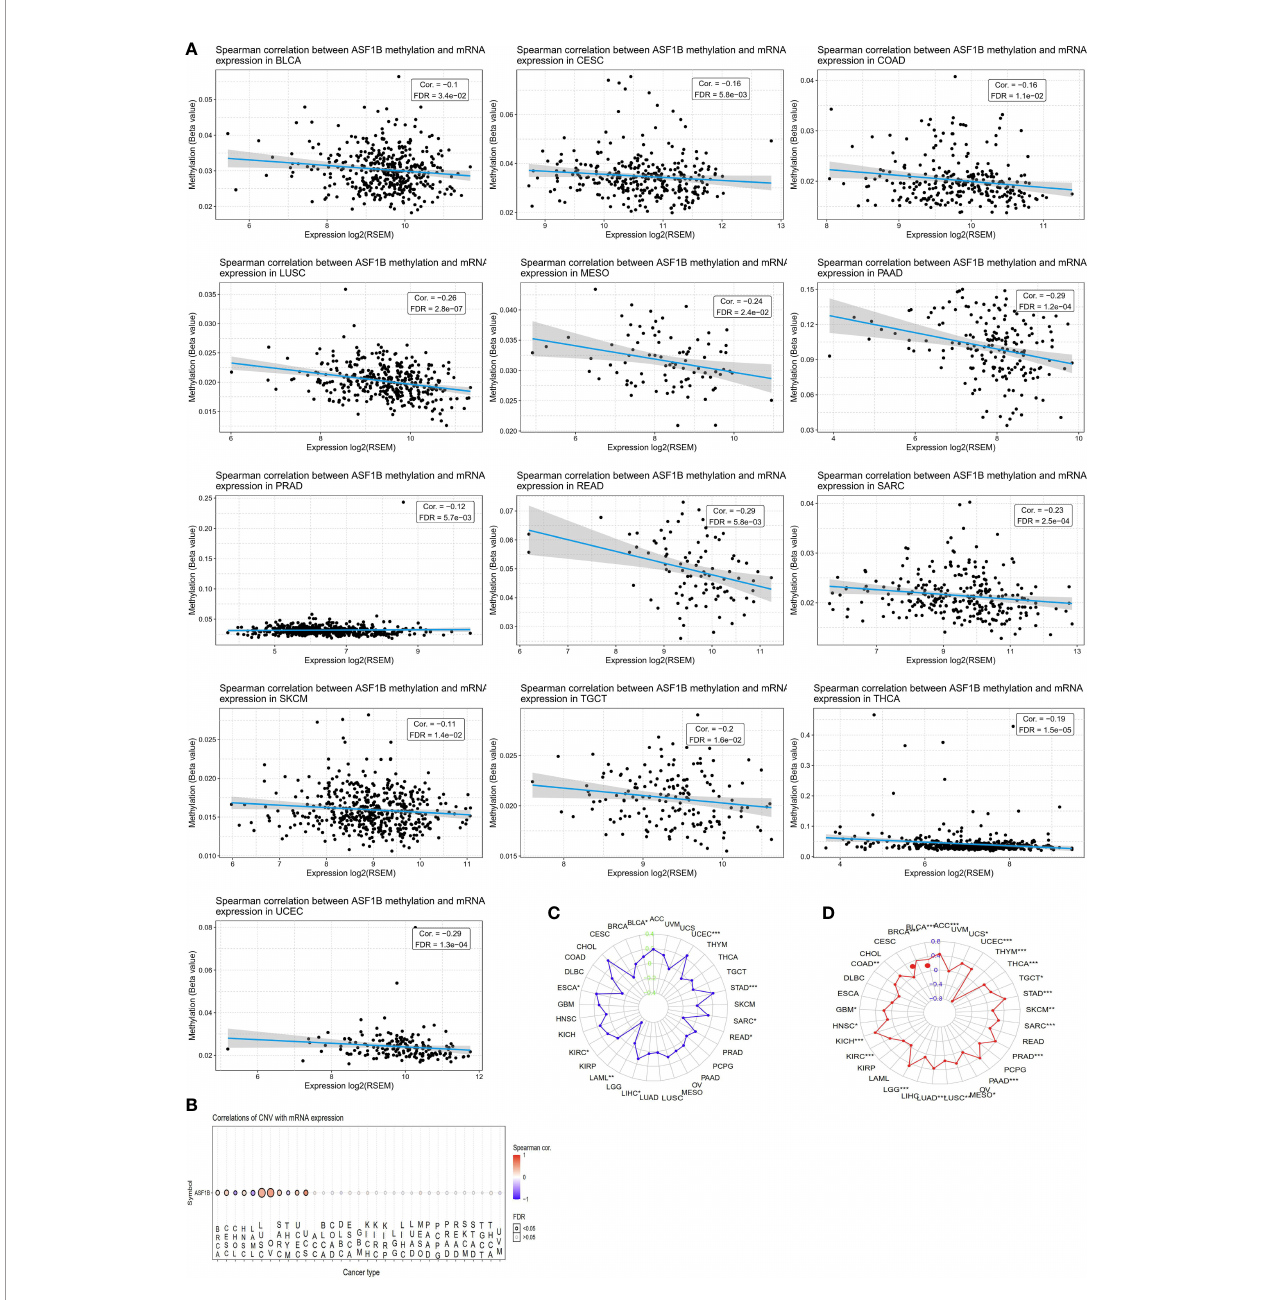
FIGURE 3 | CNV, DNA methylation, MSI and TMB of ASF1B in human cancers. (A) The relationship between methylation and ASF1B expression. DNA methylation beta values ranging from 0(unmethylated) to 1(fully methylated). (B) Correlations of CNV and ASF1B expression. (C) Correlations of TMB and ASF1B expression. (D) Correlations of MSI and ASF1B expression. *p value ≤ 0.05; **p ≤ 0.01; *** p value ≤